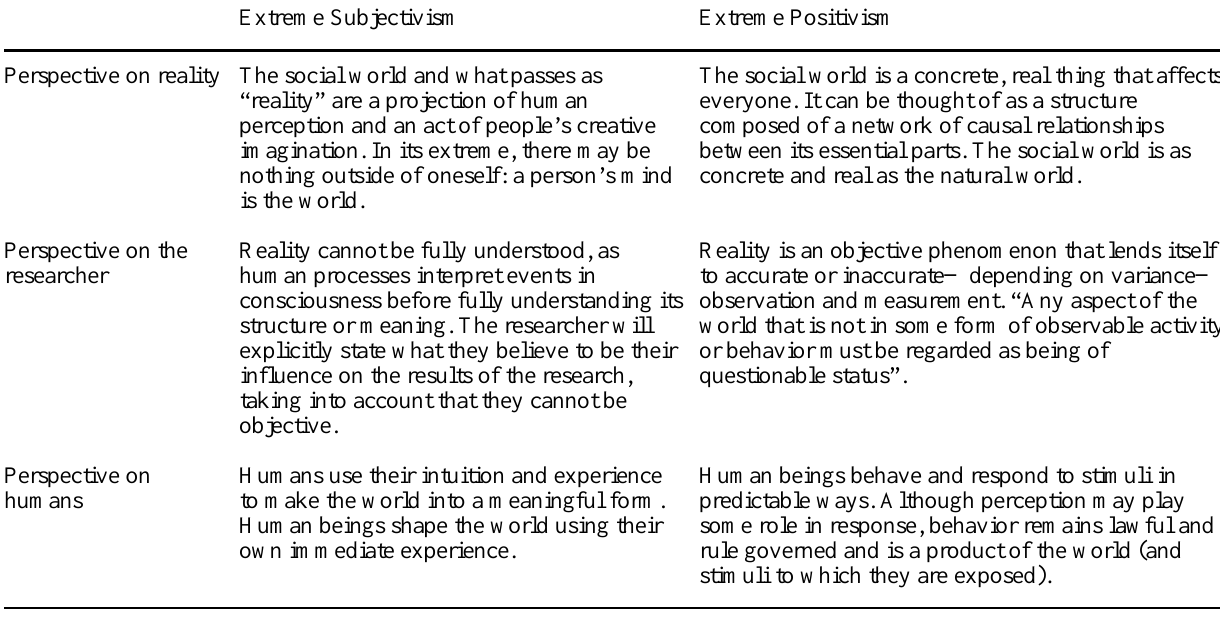
Table 1. The core ontological assumptions guiding positivism and subjectivism, adapted from a table in Morgan and Smircich